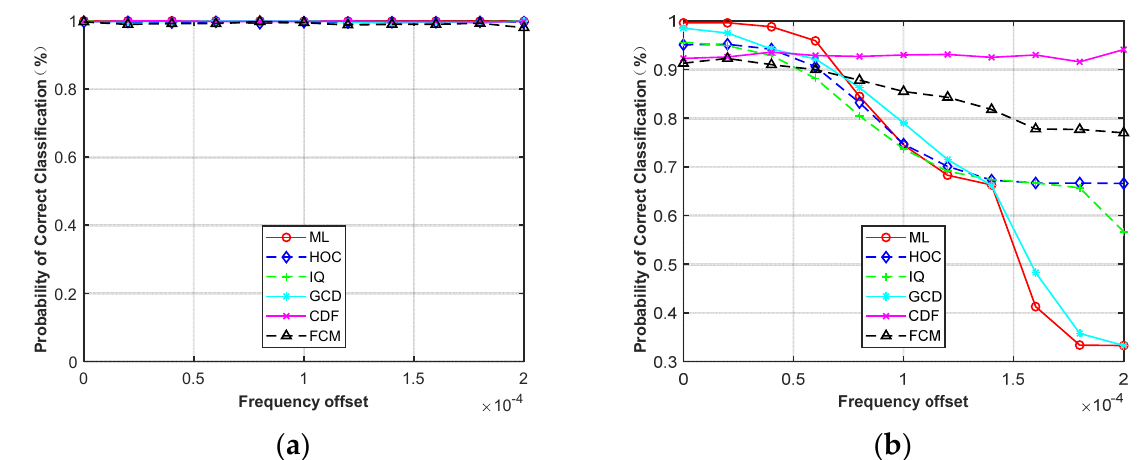
Figure 10. Probability of correct classification versus frequency offset. ( a ) MPSK (SNR = 6, N = 128). ( b ) MQAM (SNR = 10, N = 512).